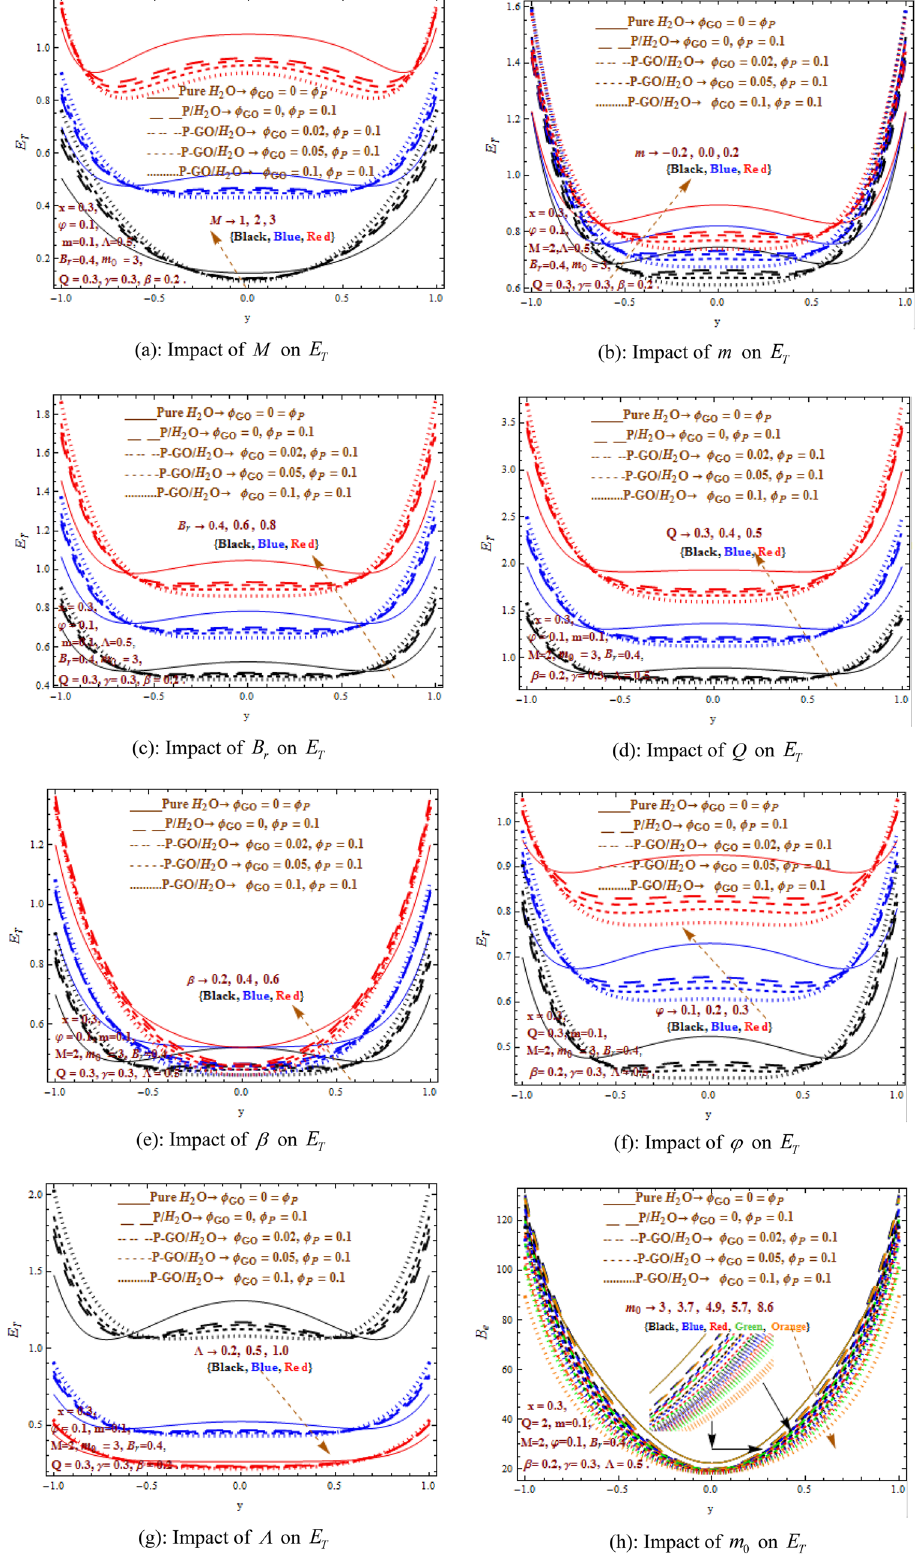
Figure 3. ( a ) Impact of M on E T . ( b ) Impact of m on E T . ( c ) Impact of B r on E T . ( d ) Impact of Q on E T . ( e ) Impact of β on E T . ( f ) Impact of ϕ on E T . ( g ) Impact of (cid:31) on E T . ( h ) Impact of m 0 on E T